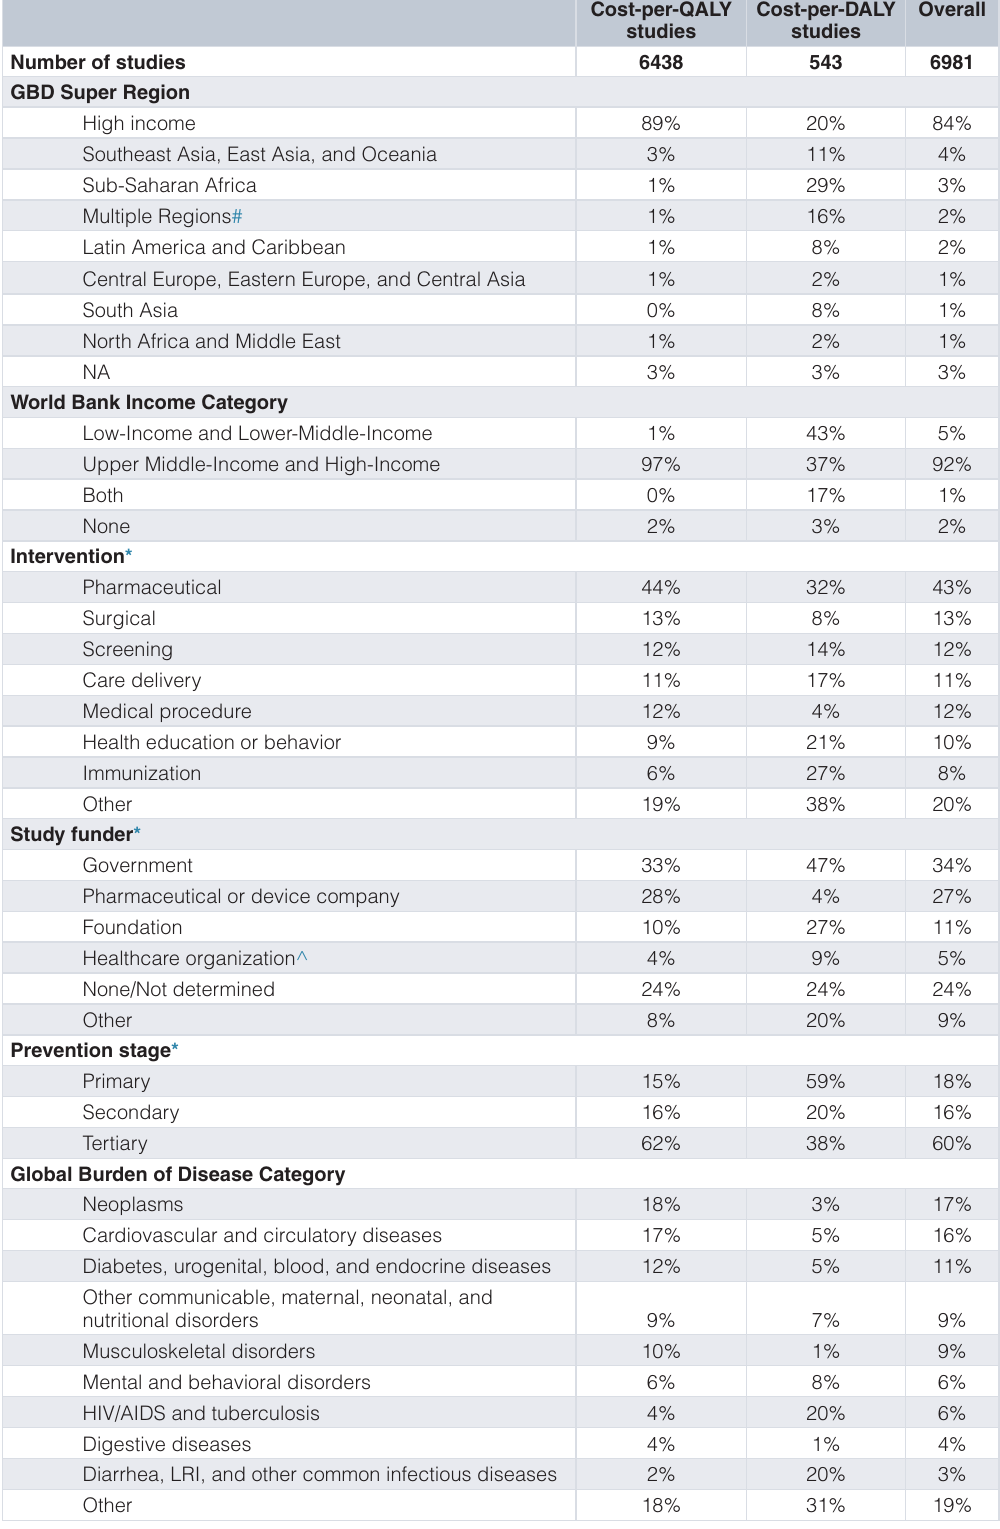
Table 1. Characteristics of published CEAs using cost-per-QALY and cost-per-DALY through